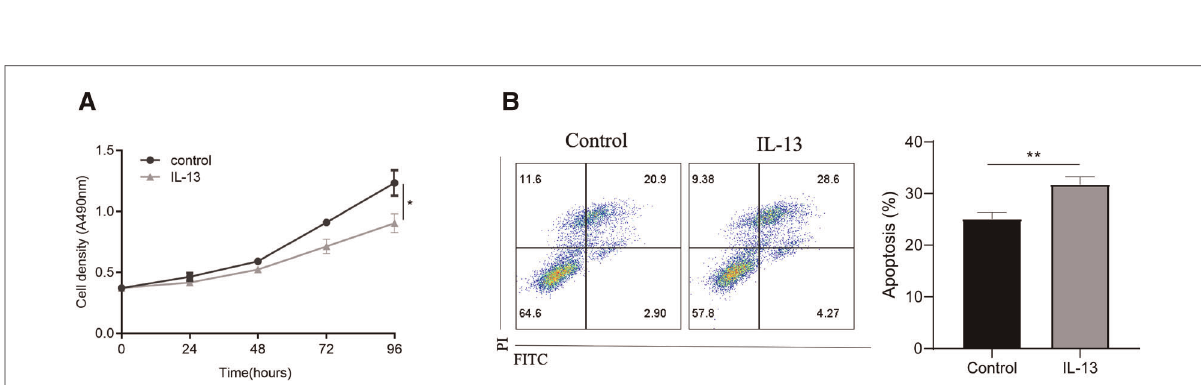
FIGURE 4 CLCA1 expression level is highly correlated with IL-13 content. ( A,B ) Person correlation analysis of the correlation of CLCA1 and IL-4 expression and the correlation of CLCA1 and IL-13 expression in the blood of healthy children and asthmatic children.